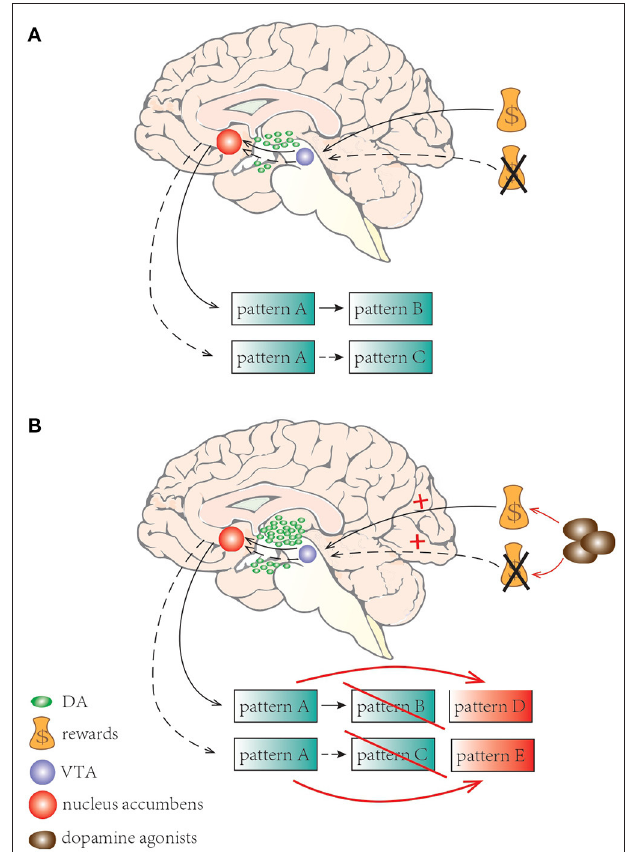
FIGURE 2 | A schematic illustration of learning process and set shifting with dopamine neurotransmission. (A) Normally, when expecting a reward or receiving an unexpected reward, phasic release of dopamine from VTA to the nucleus accumbens occurs; phasic suppression of dopamine occurs when an expecting reward is not received. Adaptive behaviors happened shifting from one pattern to a more appropriate one. (B) In PD, dopamine agonists may elicit excessive stimulation results in facilitating the appearance of ICDs. ICD patients are less sensitive to negative events but more sensitive to rewarding